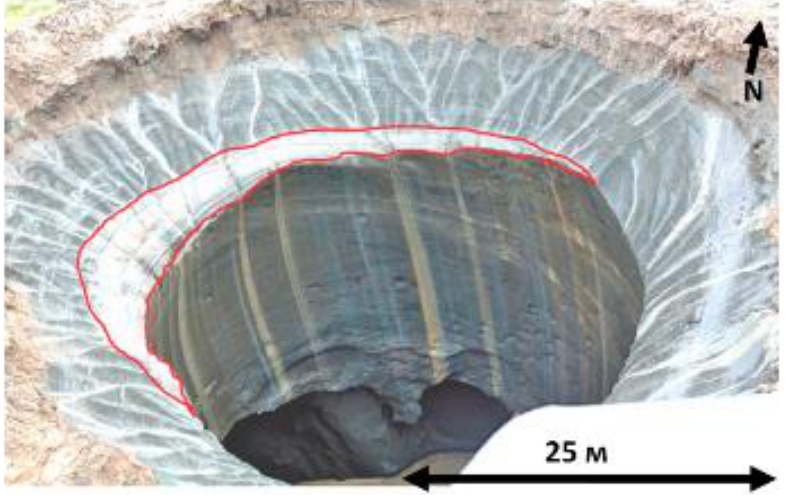
Figure 2. Zone of caverns and grottoes in the lower part of the Yamal crater. Designations: the red line marks the zone of dislocated, layered, gas-saturated ice. July 2014. Reproduced with permission from V.V. Olenchenko.